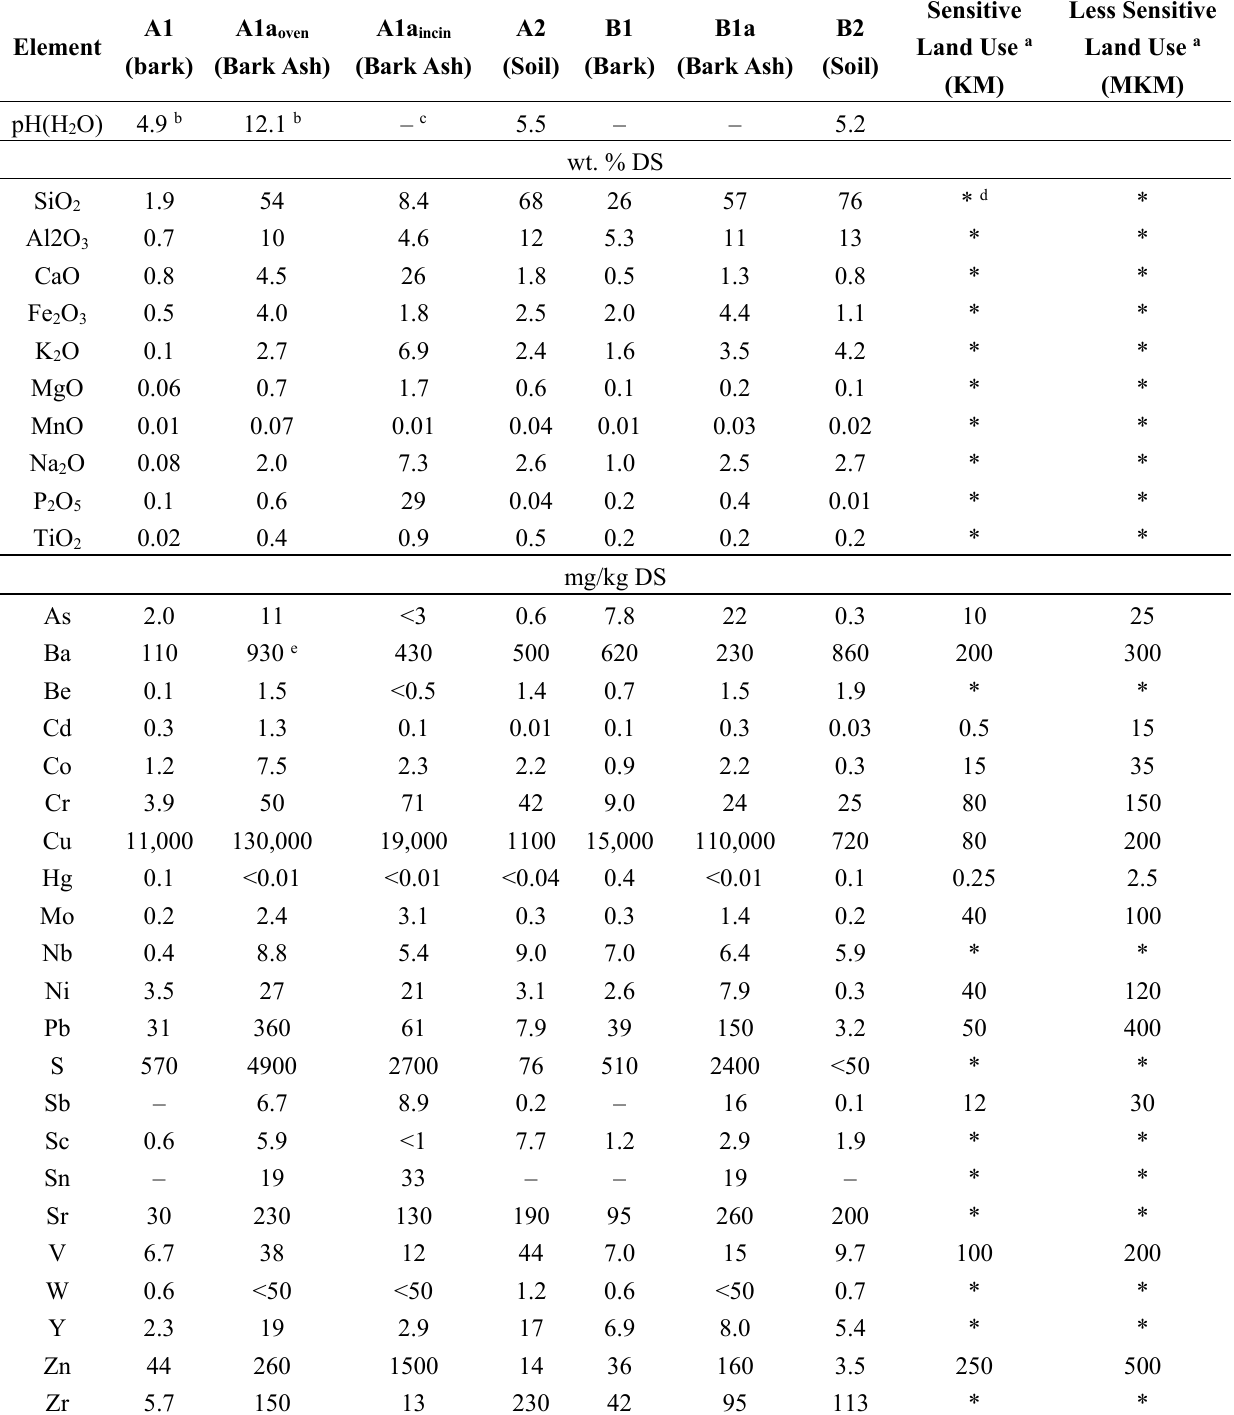
Table 1. Average total amounts of selected major (oxide minerals) and minor elements in the original soil samples (A1, A1a oven , A1a incin , A2, B1, B1a and B2). The Swedish generic guidelines values for sensitive (KM) and less sensitive (MKM) land use are also shown. All amounts are shown in mg/kg DS. Measurement uncertainties vary between 20% and